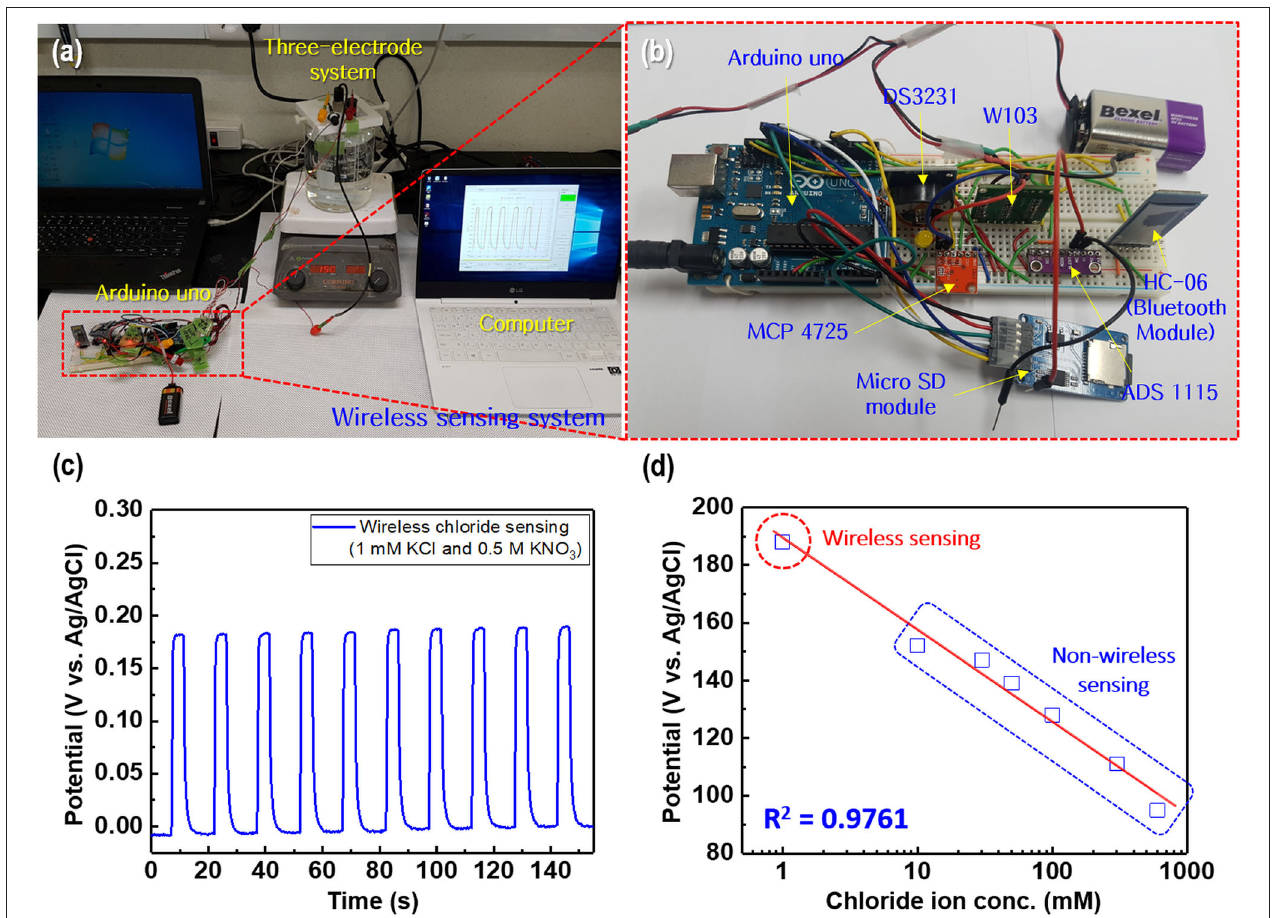
FIGURE 12 | (a) Wireless chloride ion sensing system based on Arduino Uno and (b) magnified image of the wireless sensor module. (c) Potential difference for the wireless chloride ion sensor with a regular current pulse of 1mA in the electrolyte comprising 1mM KCl and 0.5 M KNO 3 . (d) Linear fitting of the chloride ion sensor potential response to the merged experimental data of wireless and non-wireless sensing.